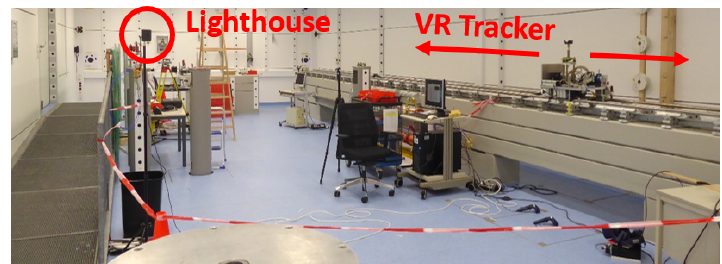
Figure 11. Setup on the horizontal comparator with one